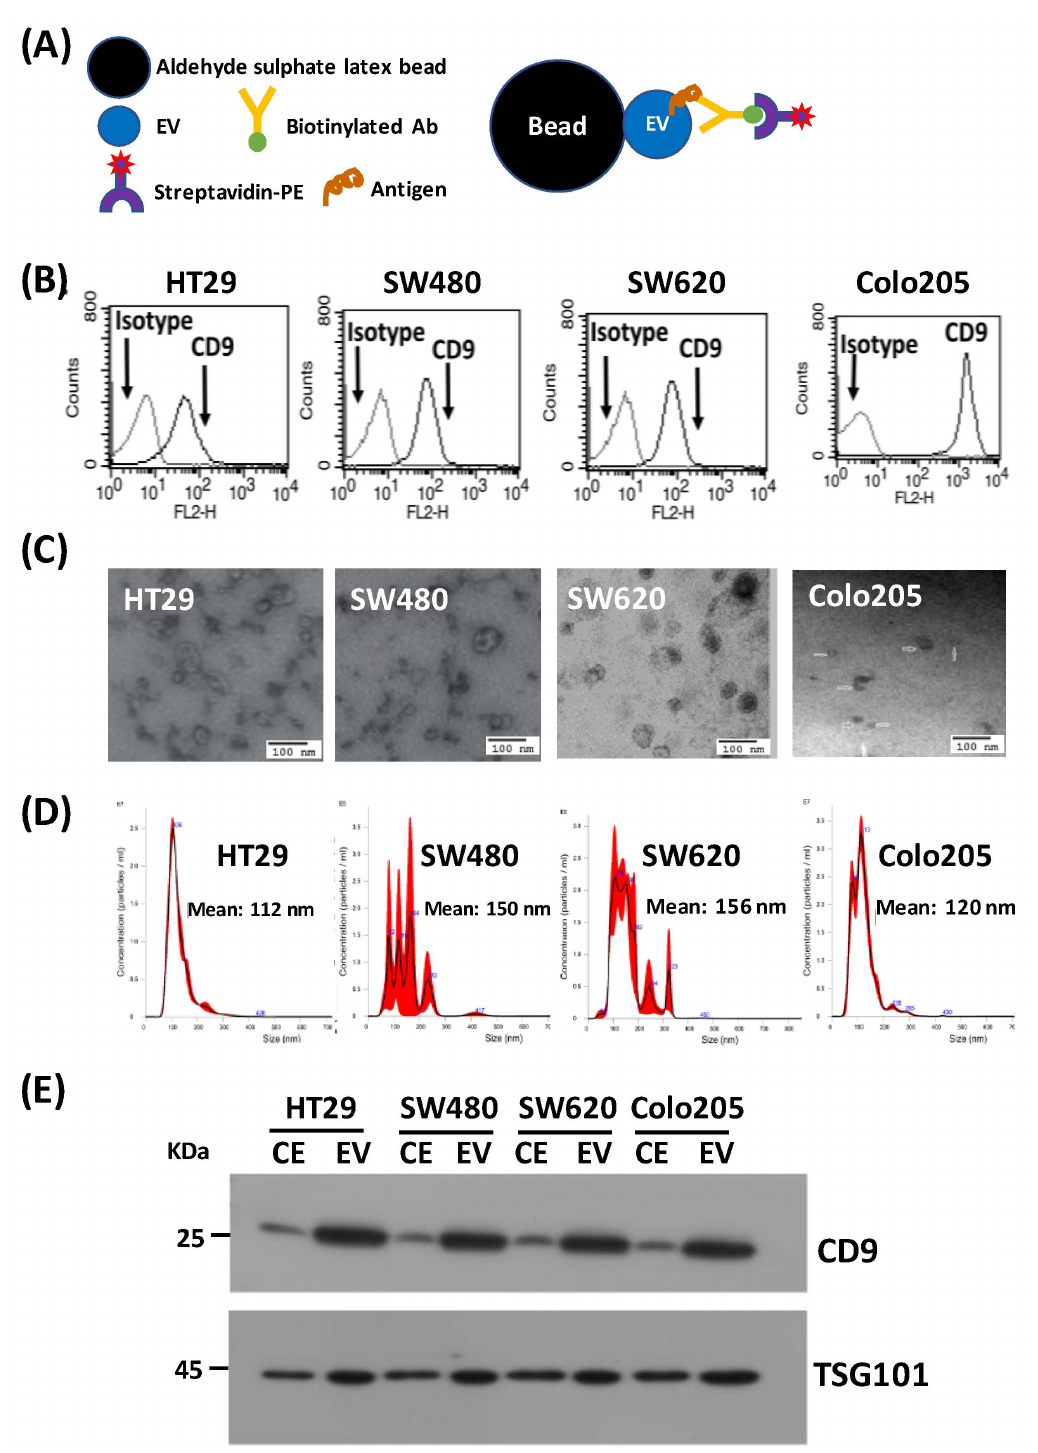
Figure 2. Characterization of EVs. ( A ) Principle of flow cytometry (FACS) analysis of EVs. ( B ) FACS analysis of CD9-positive EVs (30 µ g EVs + 10 µ L beads) released from HT29, SW480, SW620 and Colo205 cell lines. Mouse IgG1K was used as an isotype control. ( C ) Transmission electron microscopy (TEM) analysis of EVs isolated from conditioned media from the four CRC cell lines. ( D ) Determi- nation of the size distribution of EVs isolated from conditioned media of the four CRC cell lines by nanoparticle tracking analysis (NTA). ( E ) Western blot analysis of the EV markers, CD9 and TSG101, in total cell extracts (CE) and EV fractions from the four CRC cell